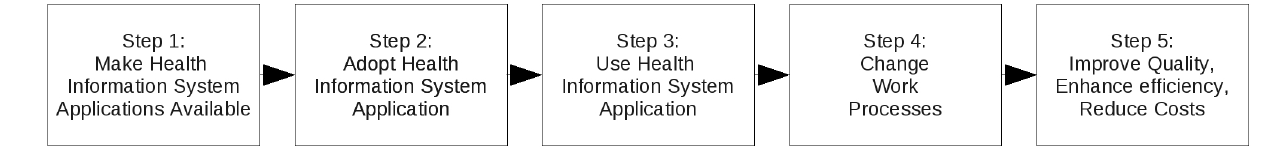
Figure 4. An illustration of the steps necessary before an HIS produces benefit